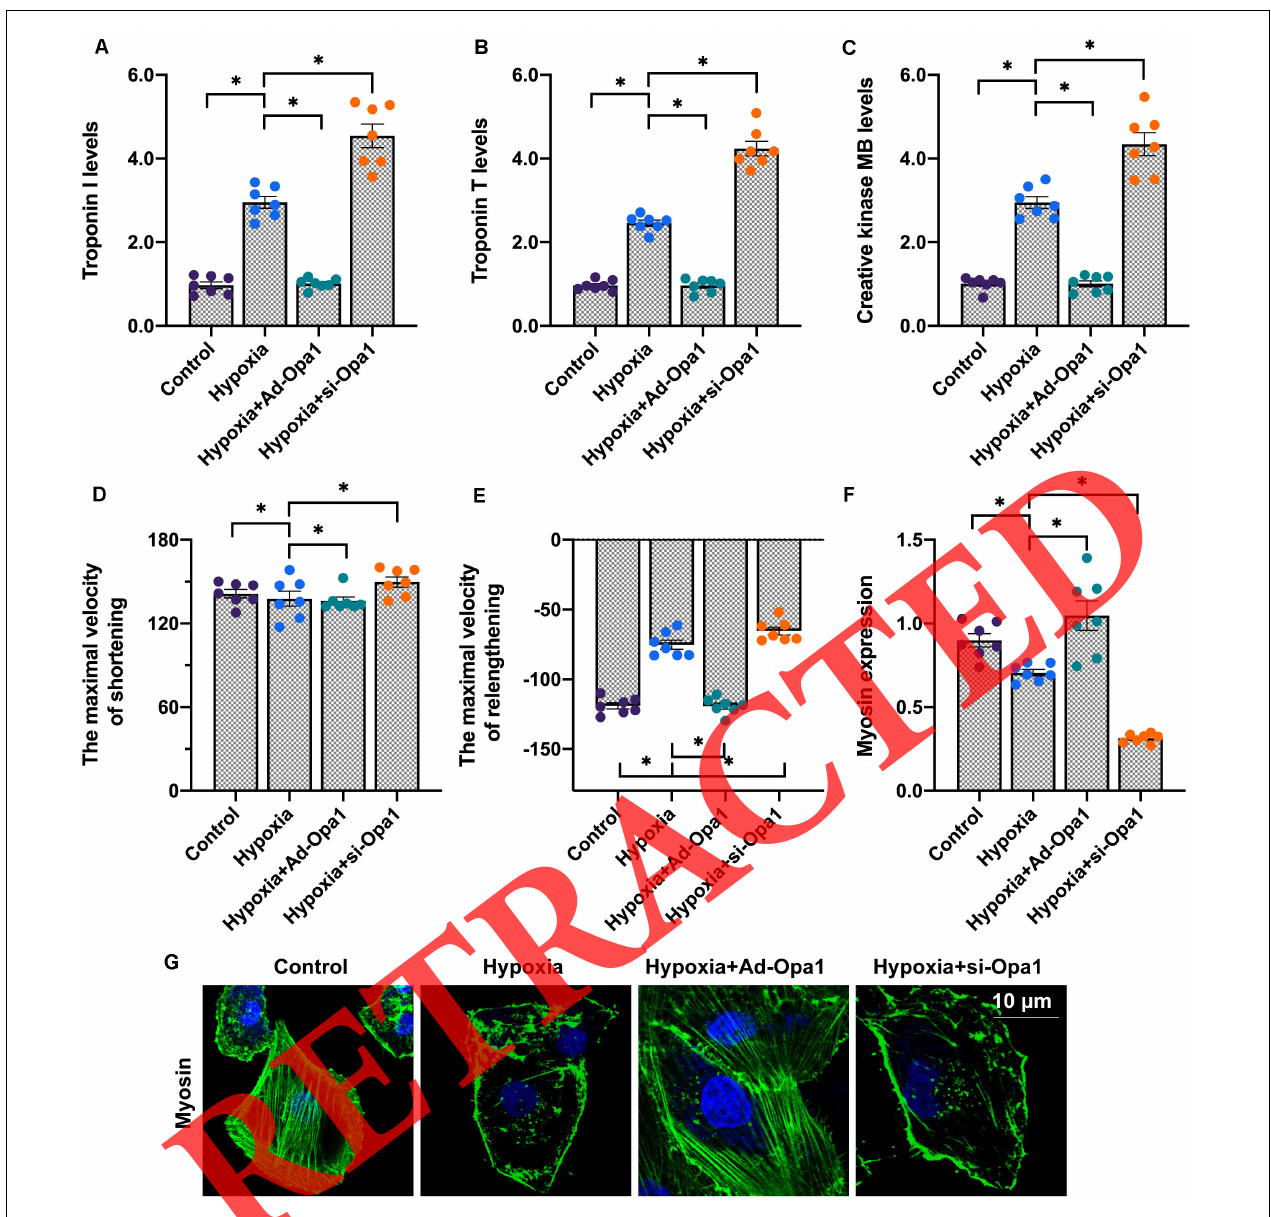
FIGURE 1 | Overexpression of Opa1 attenuates cardiac damage and dysfunction induced by hypoxic stress. (A–C) ELISA analysis of troponin T (TnT), troponin I (TnI), and creatine kinase MB (CK-MB) secretion by Opa1-overexpressing (Ad-Opa1) and Opa1-knockdown (si-Opa1) cardiomyocytes subjected to 24 h hypoxia exposure. (D,E) Analysis of cardiomyocyte contractile properties. Maximal shortening and relengthening velocities were measured using a SoftEdge MyoCam system. (F,G) Myosin immunofluorescence results. ∗ p <